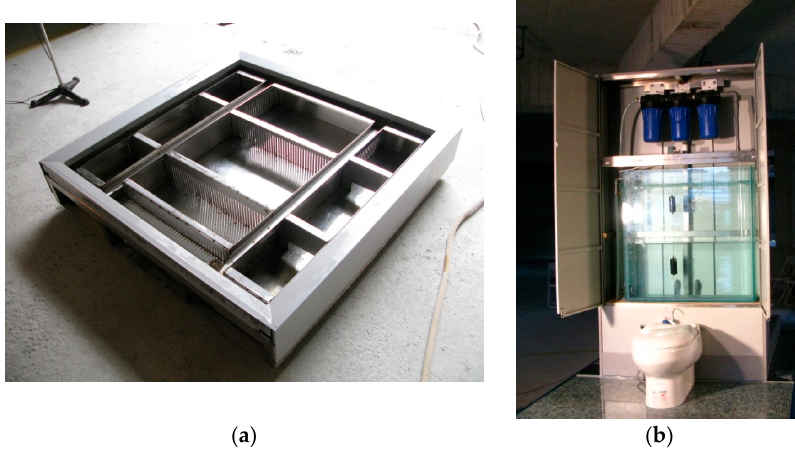
Figure 3. Prototype model of greywater processing: ( a ) Primary filtration and sedimentation; ( b ) Filtration, sterilization and water storage.